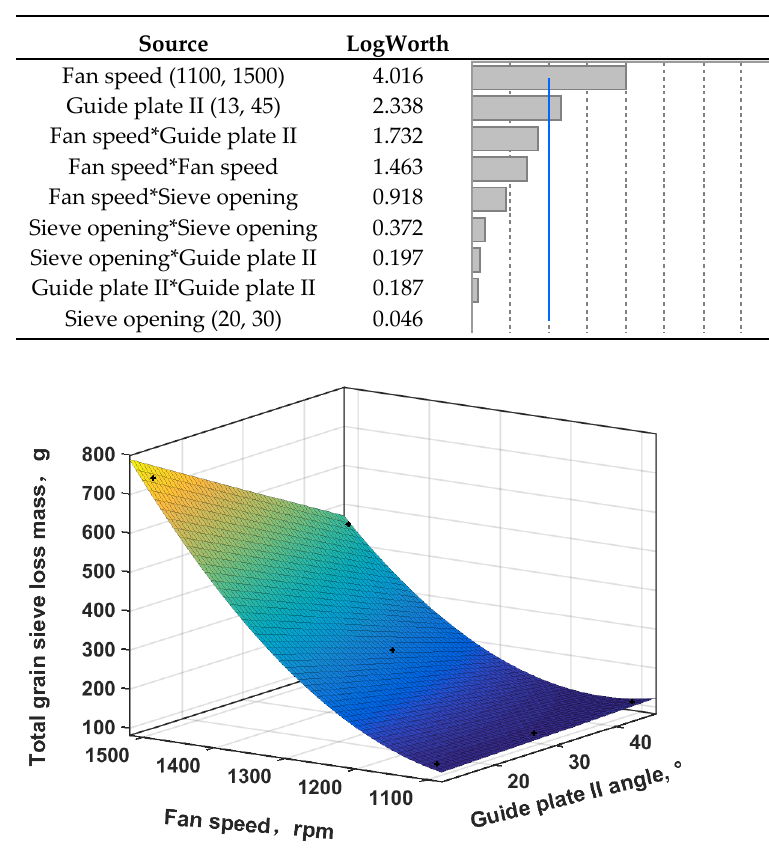
Figure 9. Effects of fan speed and guide plate II on grain sieve loss.